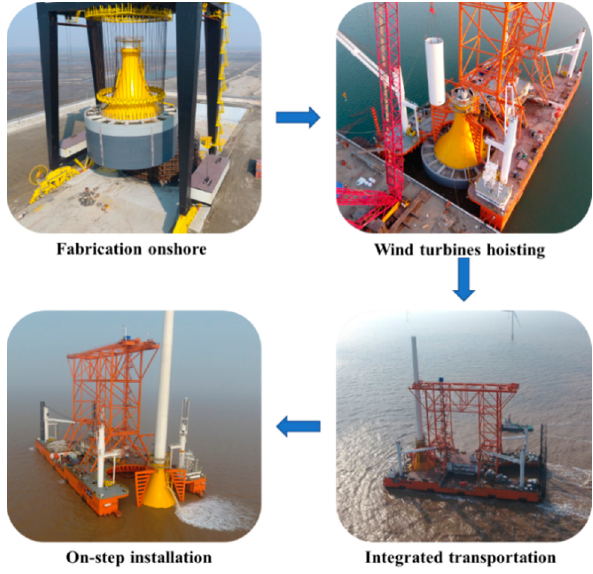
Figure 2. Construction process of the CBF.